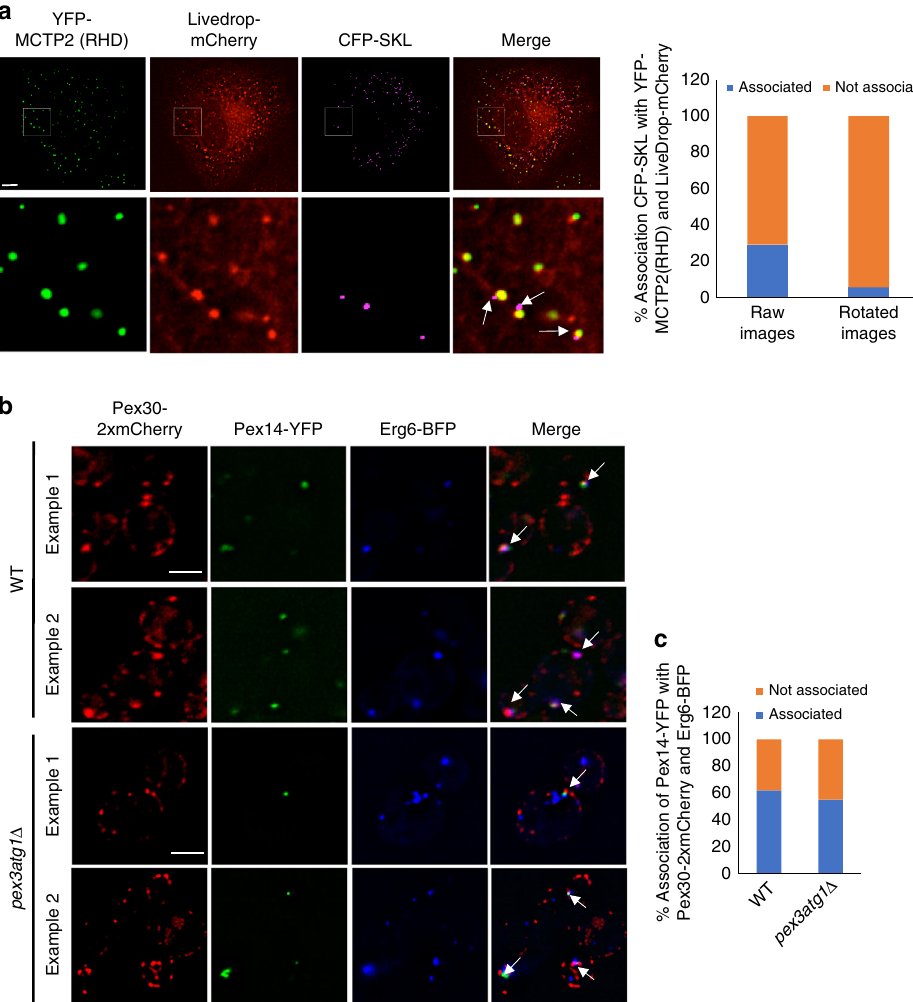
Fig. 7 Pex30/MCTP2 sites simultaneously associate with LDs and Peroxisomes/PPVs. a Images of COS7 cells transiently co-transfected with plasmids expressing YFP-MCTP2 (RHD), LiveDrop-mCherry, and CFP-SKL (a peroxisome marker). Stacks of 20 images with a step size of 0.3 μ m were deconvolved; images from single plane are shown. Bar = 5 μ m. Graph shows percent association of CFP-SKL puncta associated with YFP-MCTP2(RHD) and LiveDrop- mCherry, from raw images or where the CFP-SKL images was rotated 90 degrees, n = 300 CFP-SKL punctae. b Images of WT and pex3atg1 Δ cells expressing endogenously tagged Pex30-2xmCherry and Pex14-YFP (a PPV marker) and Erg6-BFP from plasmids. Stacks of three images with a step size of 0.25 μ m were deconvolved; images from single plane are shown. Bar = 3 μ m. c Quanti fi cation of experiments in b indicating percent association of